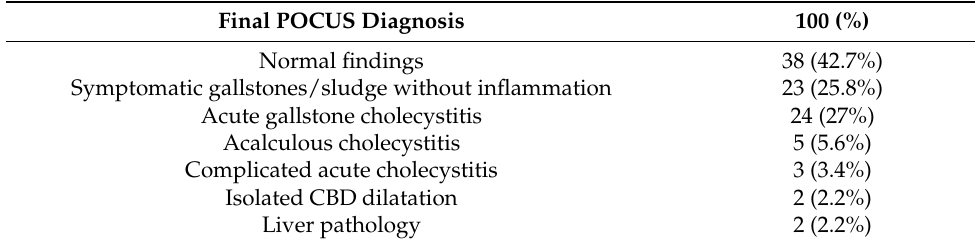
Table 2. Final POCUS diagnoses of the patients recruited to the